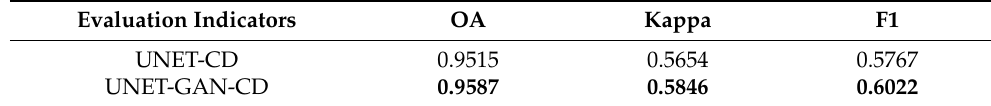
Table 5. Accuracy comparison of change detection results.